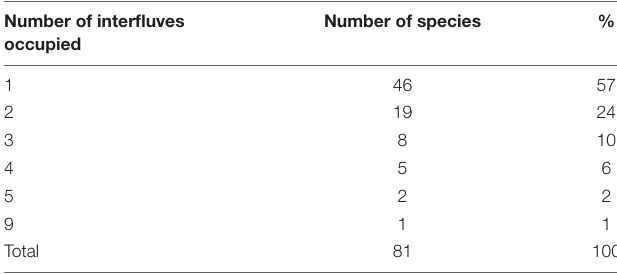
TABLE 2 | Frequency of occurrence of primate species in the major interfluves of the Brazilian Amazonia. Number of interfluves